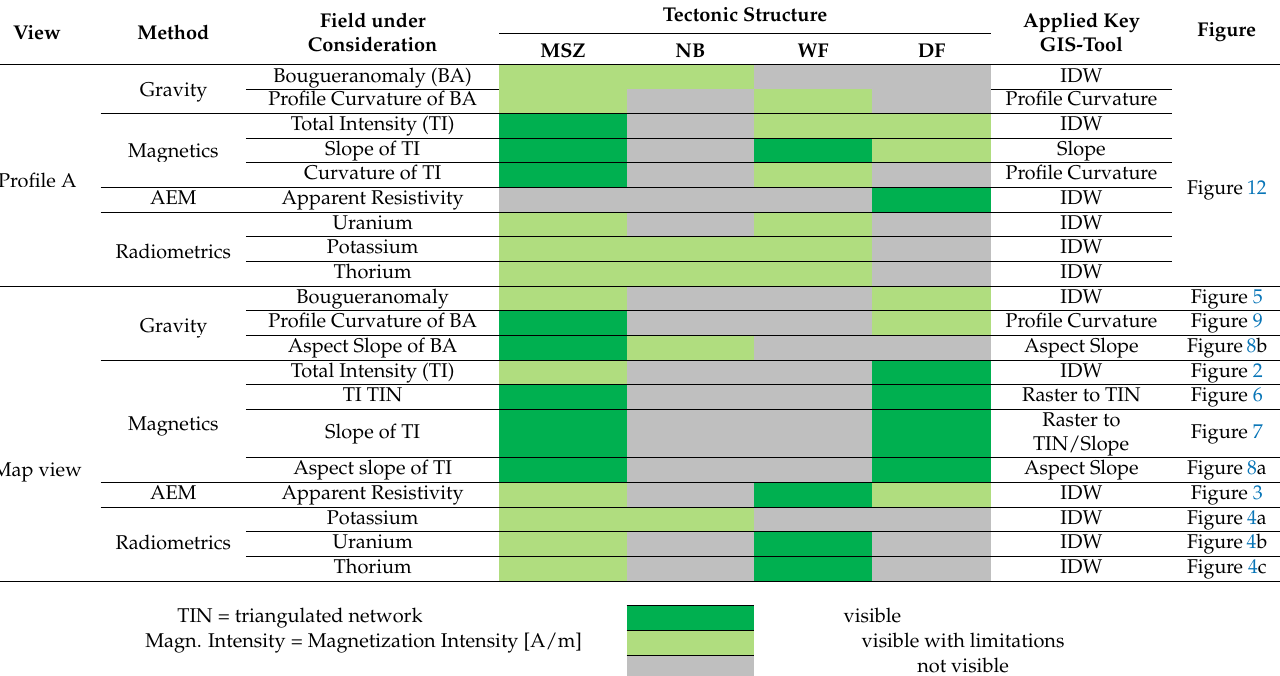
Table 2. Summary of the interpreted results and an evaluation of their applicability to each of the major faults within the study